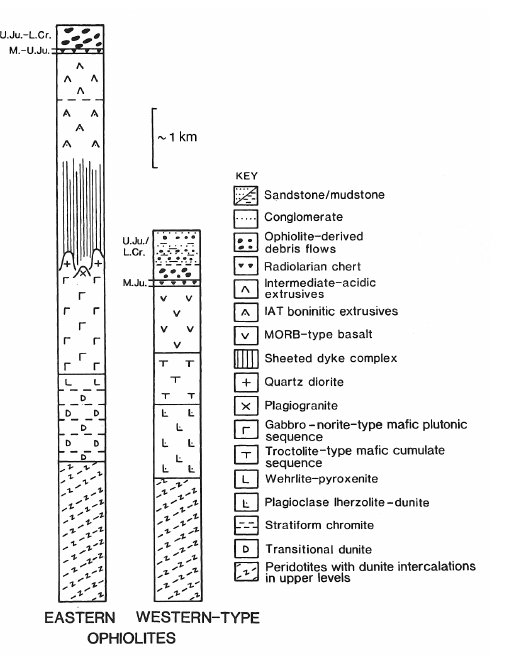
Fig. 3. Summary logs of the western and eastern ophiolites, Midrita zone (Robertson and Shallo,